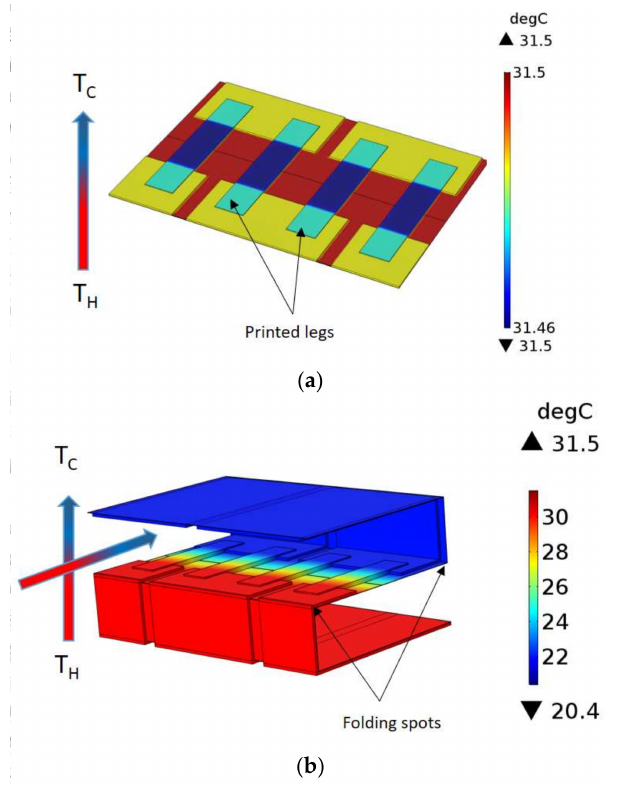
Figure 3. Folding and its effect on the total thermal distribution—( a ) flat TEG, ( b ) folded TEG.